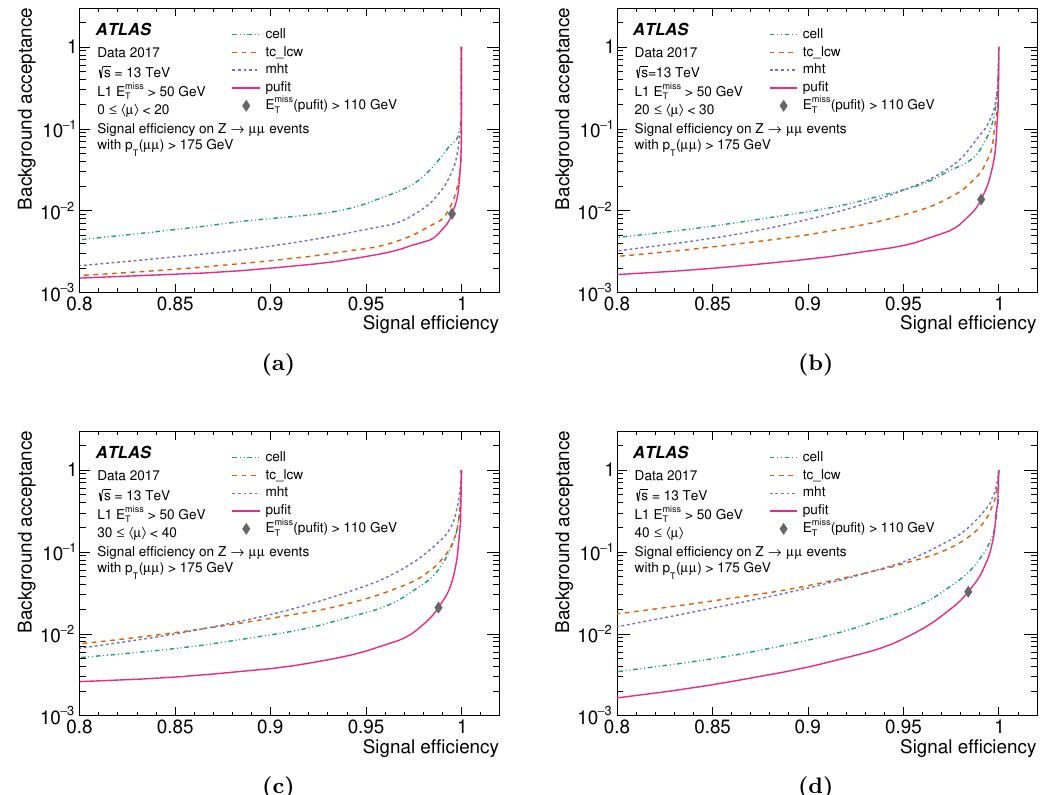
Figure 5. Background acceptance vs signal e(cid:14)ciency for each of four individual HLT E miss algorithms for a Z ! (cid:22)(cid:22) selection with p T ( (cid:22)(cid:22) ) > 175 GeV for data recorded in the year 2017. The diamond indicates the performance of the pufit E miss panels shows a di(cid:11)erent range of h (cid:22) i : (a) 0 (cid:20) h (cid:22) i < 20, (b) 20 (cid:20) h (cid:22) i < 30, (c) 30 (cid:20) h (cid:22) i < 40 and (d) 40 (cid:20) h (cid:22) i